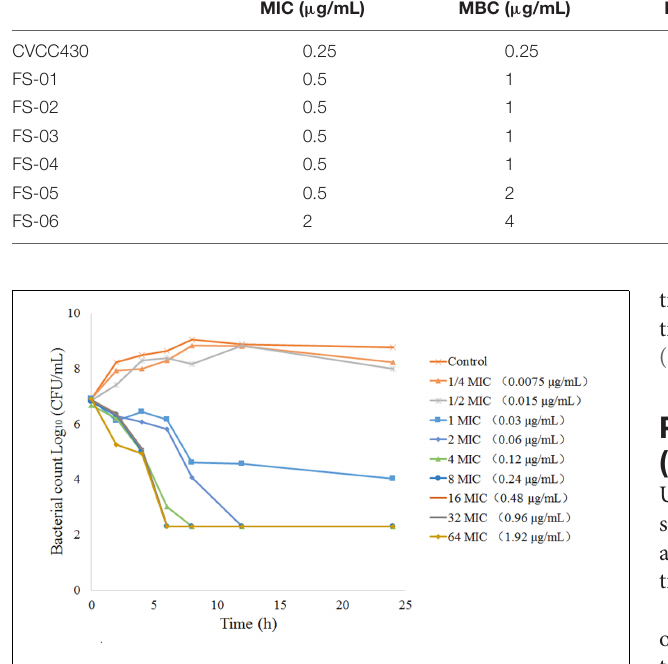
FIGURE 3 | In vitro time-kill curves for tulathromycin concentration range 0.25-64 MIC against P. multocida CVCC430 in serum.